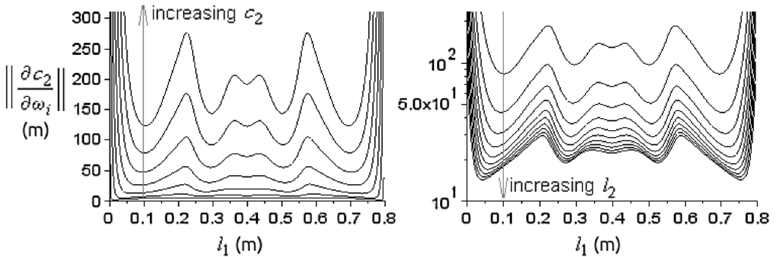
Figure 11. The graph of norm (22) as a function of l 1 for constant l 2 and different values of c 2 (left); and for constant c 2 and different values of l 2 (right, vertical log scale). On the left, l 2 = 18.16 mm and c 2 = 1000–6000 m/s at steps of 1000 m/s, for the same ρ 2 . On the right, c 2 = 5018 m/s and l 2 =1–10 cm at steps of 1 cm. The first N = 4 resonances were used.